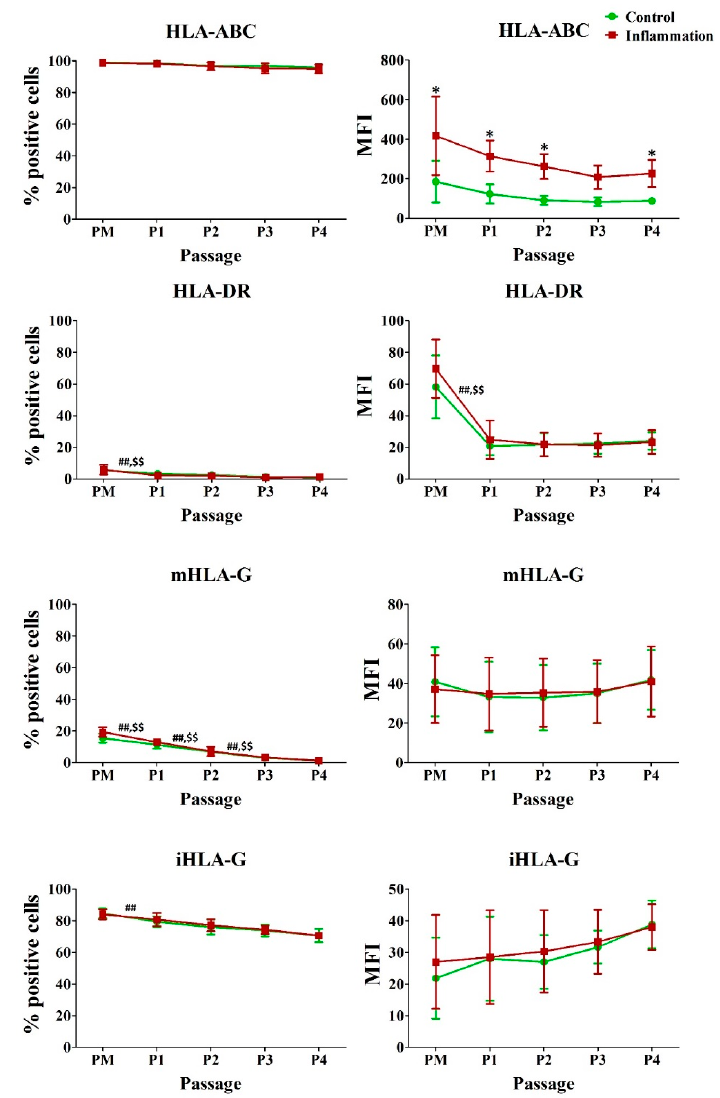
Figure 2. Impact of inflammation and cell passaging on the expression of human leukocyte antigens in AT-MSCs. Flow cytometric analysis was used to determine the percentage of positive cells and the protein expression per cell (MFI). The values are expressed as mean ± SD and originate from six di ff erent AT-MSC donors. * Significantly higher percentage or amount per cell in inflammation-stimulated AT-MSCs compared to regular AT-MSCs ( p -value < 0.05). ## Significantly lower percentage or amount per cell in regular AT-MSCs compared to the consecutive passage ( p -value < 0.05). $$ Significantly lower percentage or amount per cell in inflammation-stimulated AT-MSCs compared to the consecutive passage ( p -value <